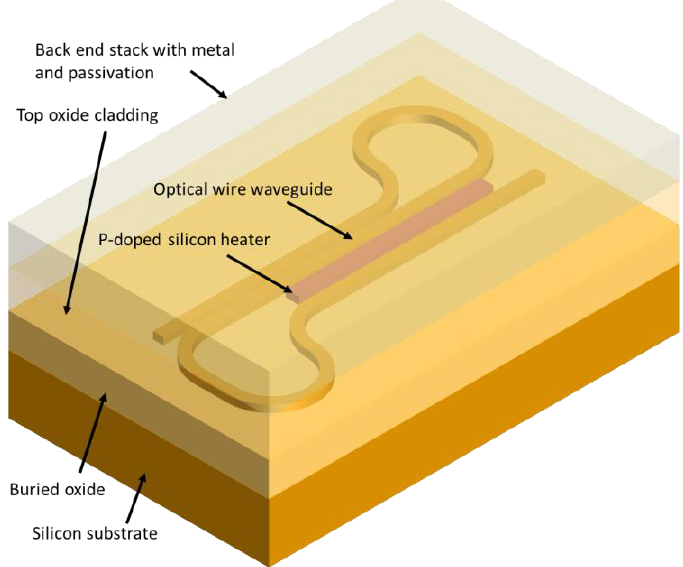
Figure 1. Schematic representation of the thermo-optic phase shifter implementation, where the optical waveguide is wrapped around a doped silicon line.